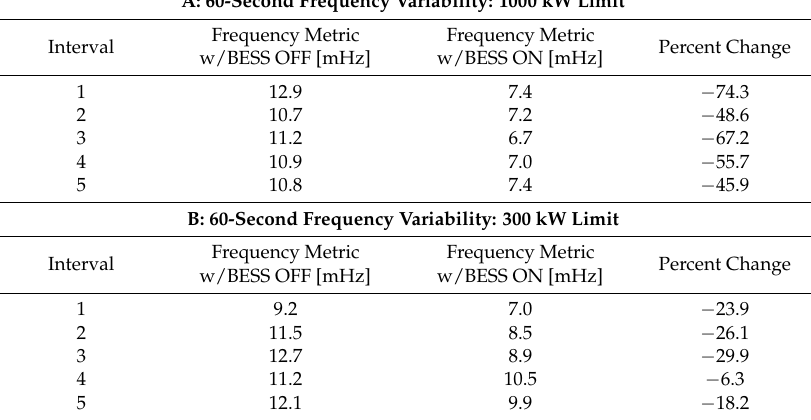
Table 3. The 60-seconds frequency variability metric for the 20-min periods with BESS OFF against adjacent 20-min periods with BESS ON show in Figure 10. A: Results for the evening with high winds and the BESS allowed to use full rated power of 1 MW; B: Results for the evening with similar high winds and the BESS allowed to use 300 kW of power.